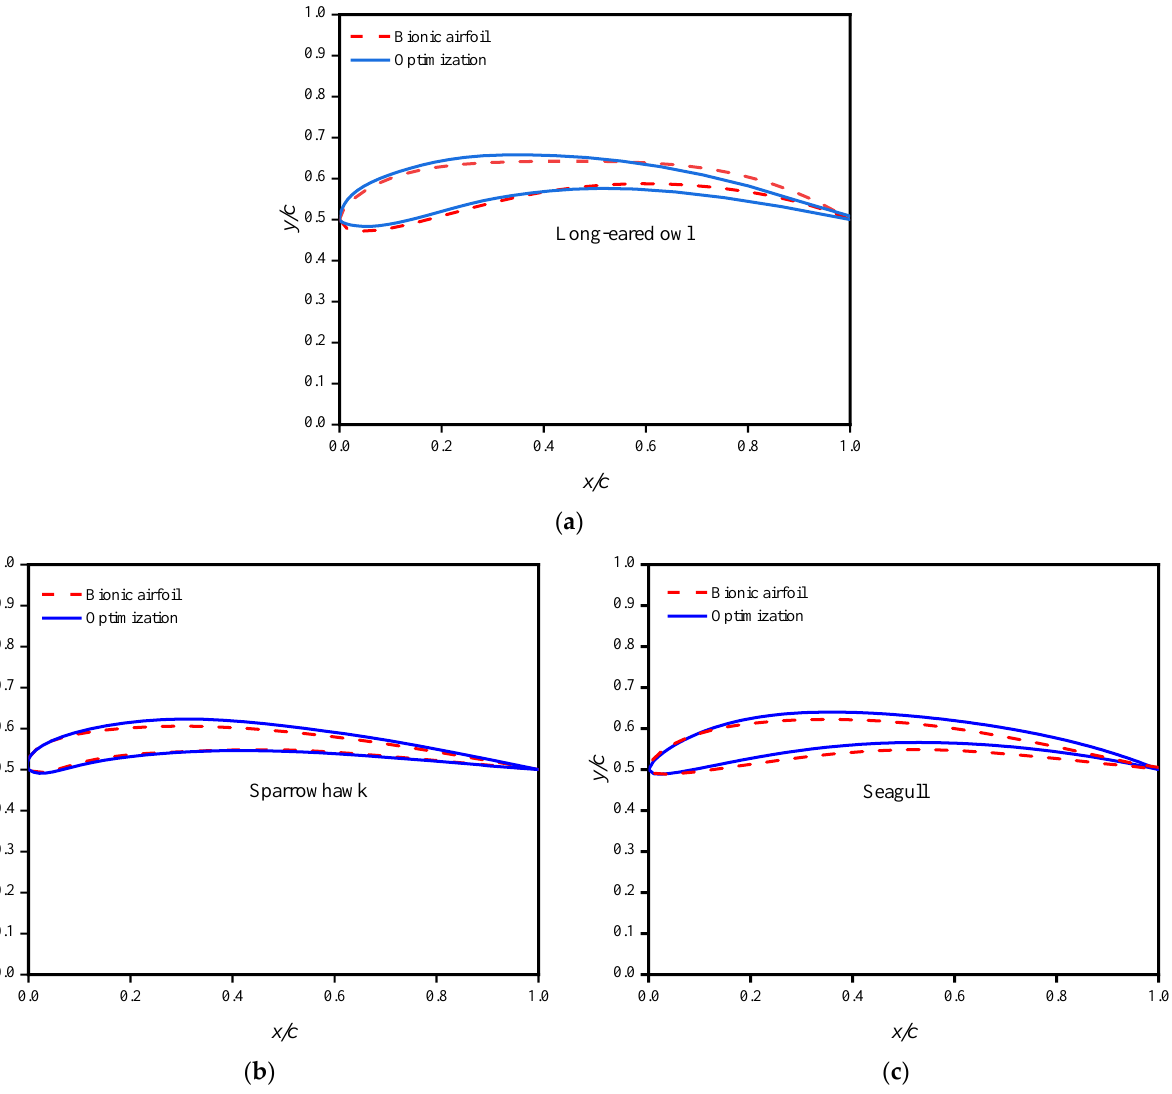
Figure 9. Bionic airfoil shapes before and after optimization. ( a ) Long-eared owl airfoil; ( b ) Spar- rowhawk airfoil; ( c ) Seagull airfoil. Table 3. Comparison of airfoil structures before and after optimization.